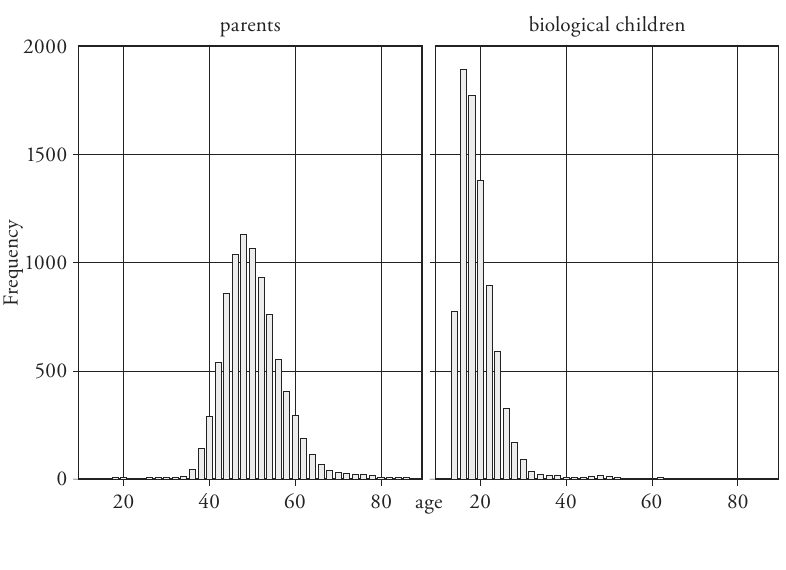
Figure 3: BMI Distribution of Parents and their Biological